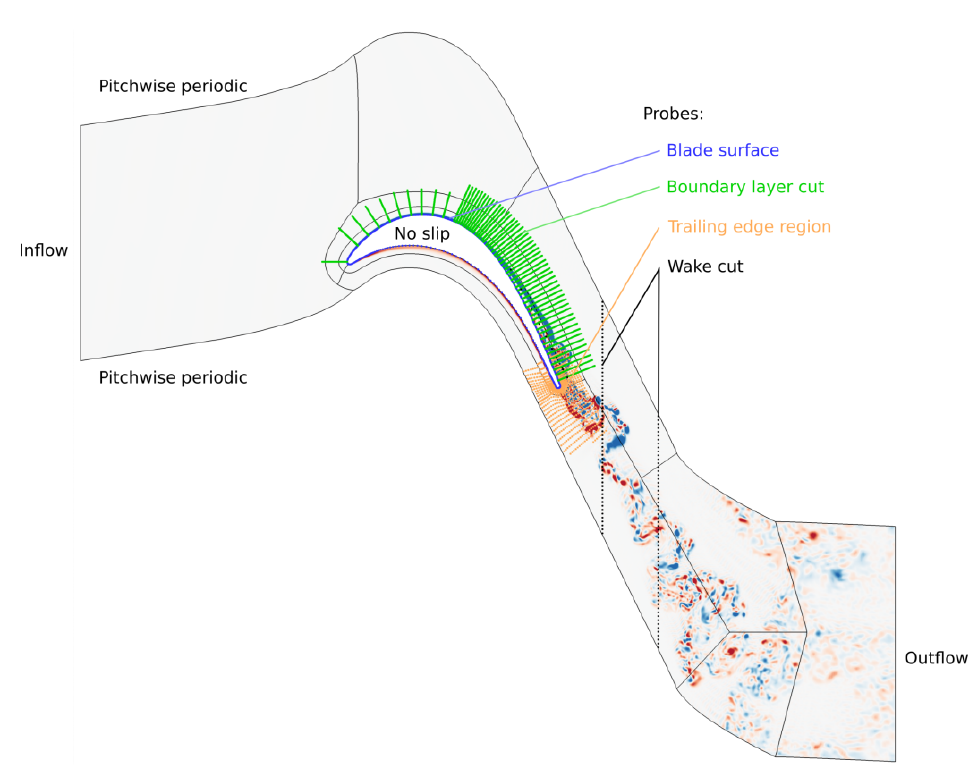
Figure 4. Overview of the CFD domain of a T106C low-pressure turbine. Data used for the present work come from the second “Wake cut”, on the right-hand side. Figure extracted from Bergmann et al. [39]. The other probe positions are not used in this